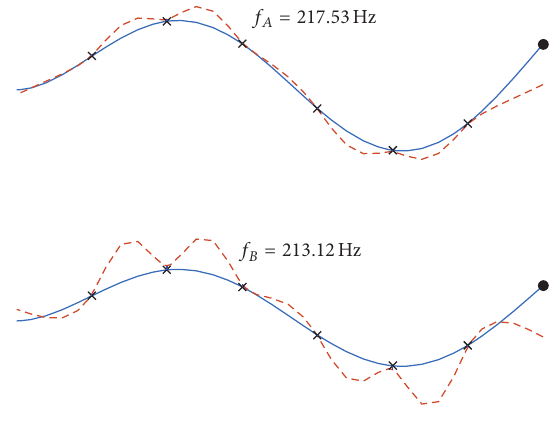
Figure 12: Mode shapes of 𝐴 , 𝐵 points.